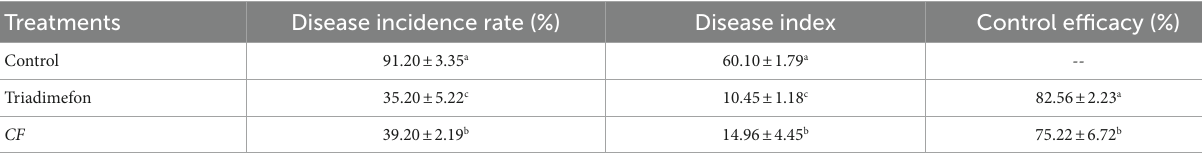
TABLE 2 Control effect of DB2 on common root rot in the greenhouse.